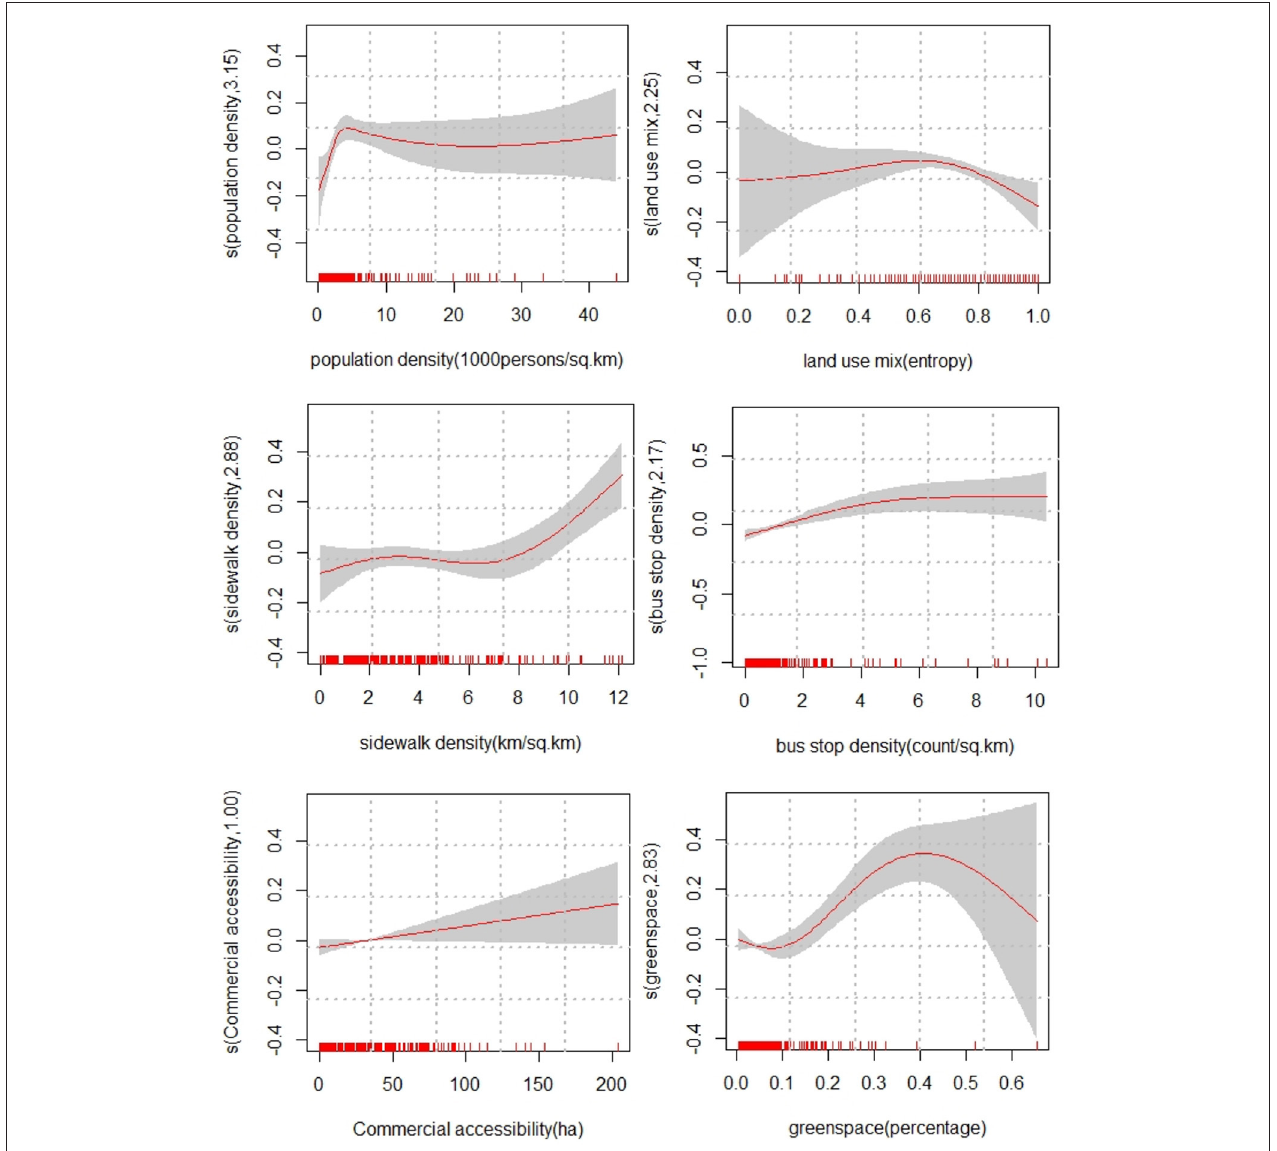
FIGURE 2 | The relationships between built environment variables and walking frequency among old adults. The numbers shown on the vertical axis in each plot indicate the estimated degrees of freedom. Solid lines represent the estimated effects of built environment variables. Shaded regions denote the 95% confidence intervals. The estimated curves are centered around zero because of the identifiability